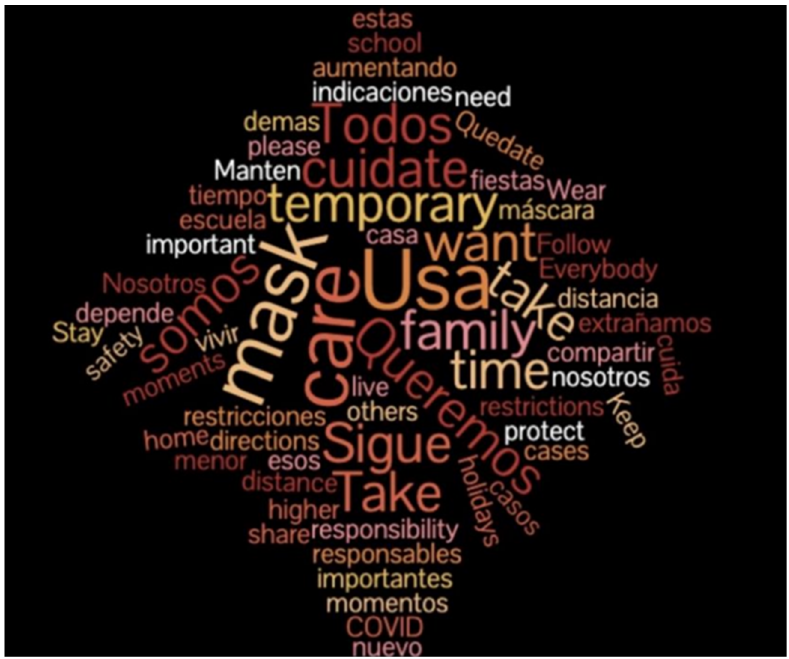
Figure 2. Word cloud summary of the bilingual script of a video created by a learner for her peers to promote mask wearing to prevent COVID-19.